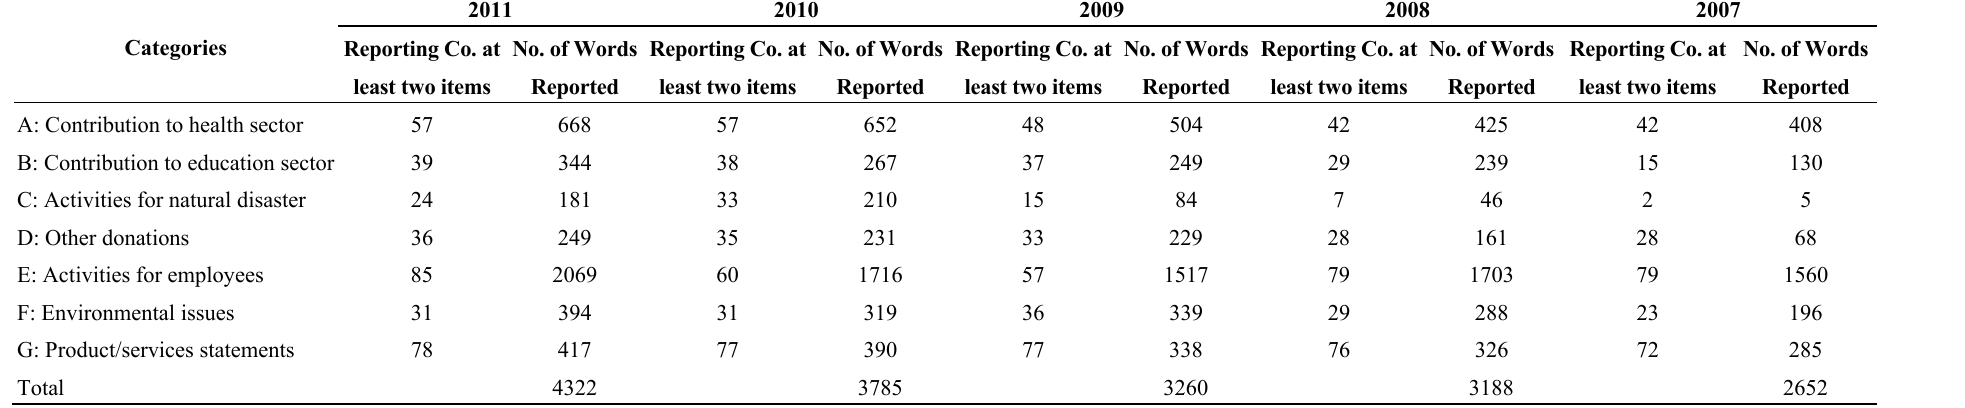
Table A3. CSR Reporting Based on Each Category of CSRD